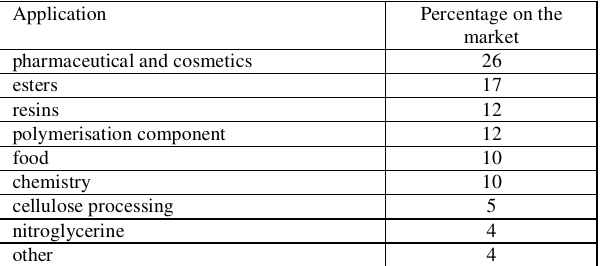
Table 1. Share of glycerine applications in the market [5]